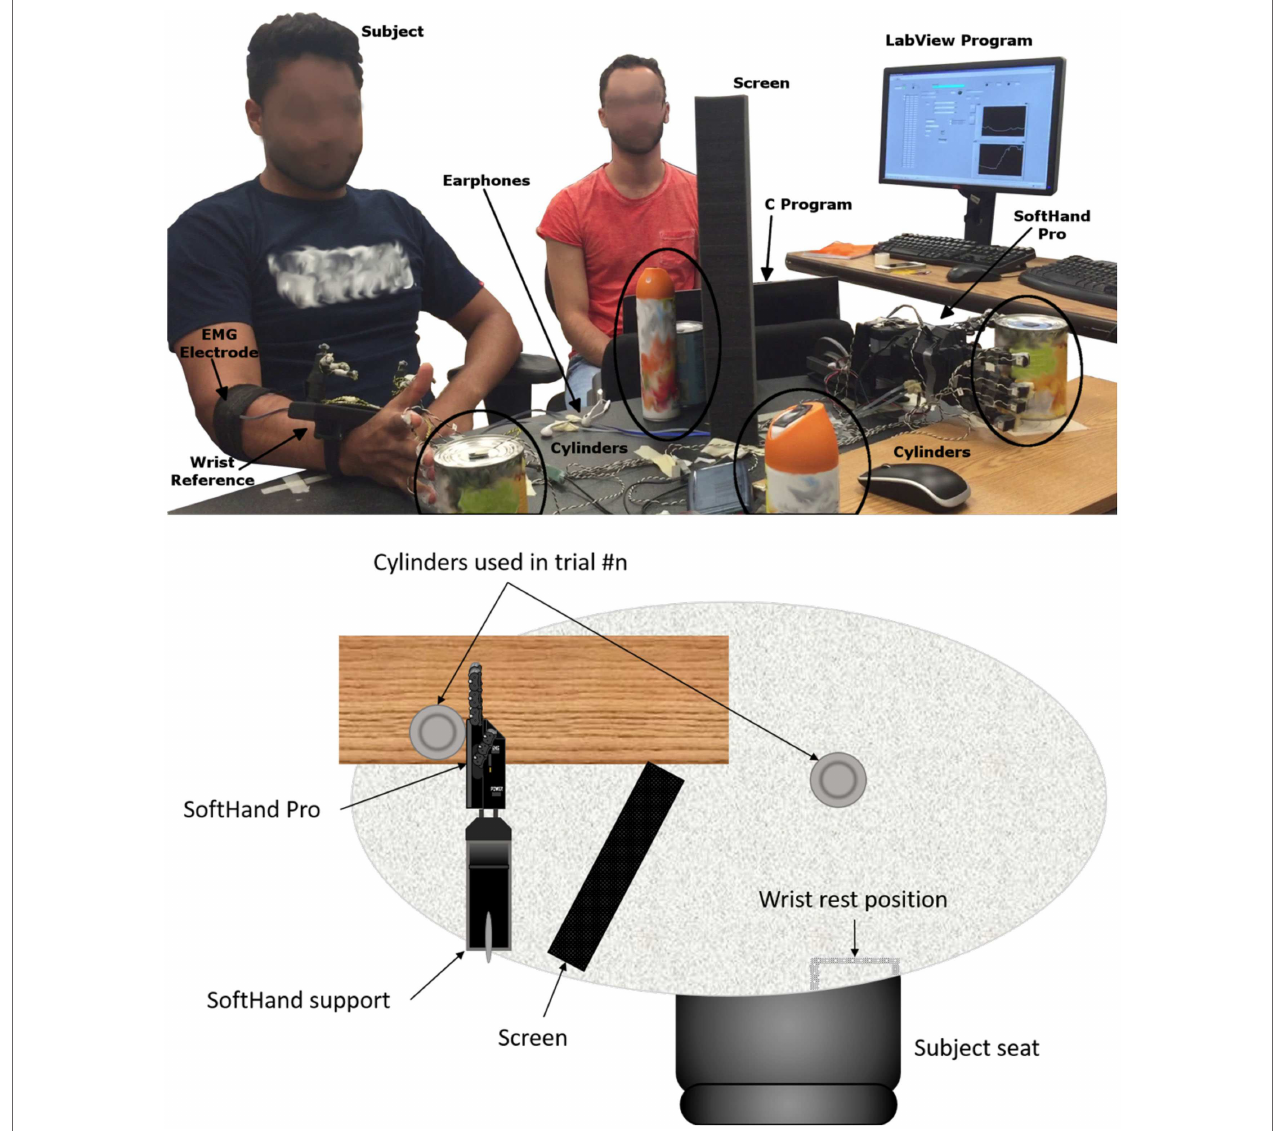
FIGURE 2 | Experiment 3 : experimental setup